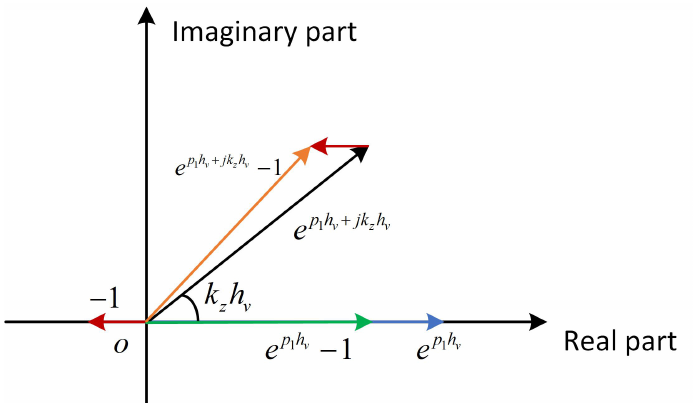
Figure 5. Geometric interpretation of the second part of the RVoG function. The blue vector denotes e p 1 h v . After rotating a angle of k z h v , e p 1 h v becomes e p 1 h v + jk z h v denoted by the black vector. The red vector is − 1. The green vector presents e p 1 h v − 1. The orange vector denotes e p 1 h v + jk z h v − 1, which is the vector sum of e p 1 h v + jk z h v and −